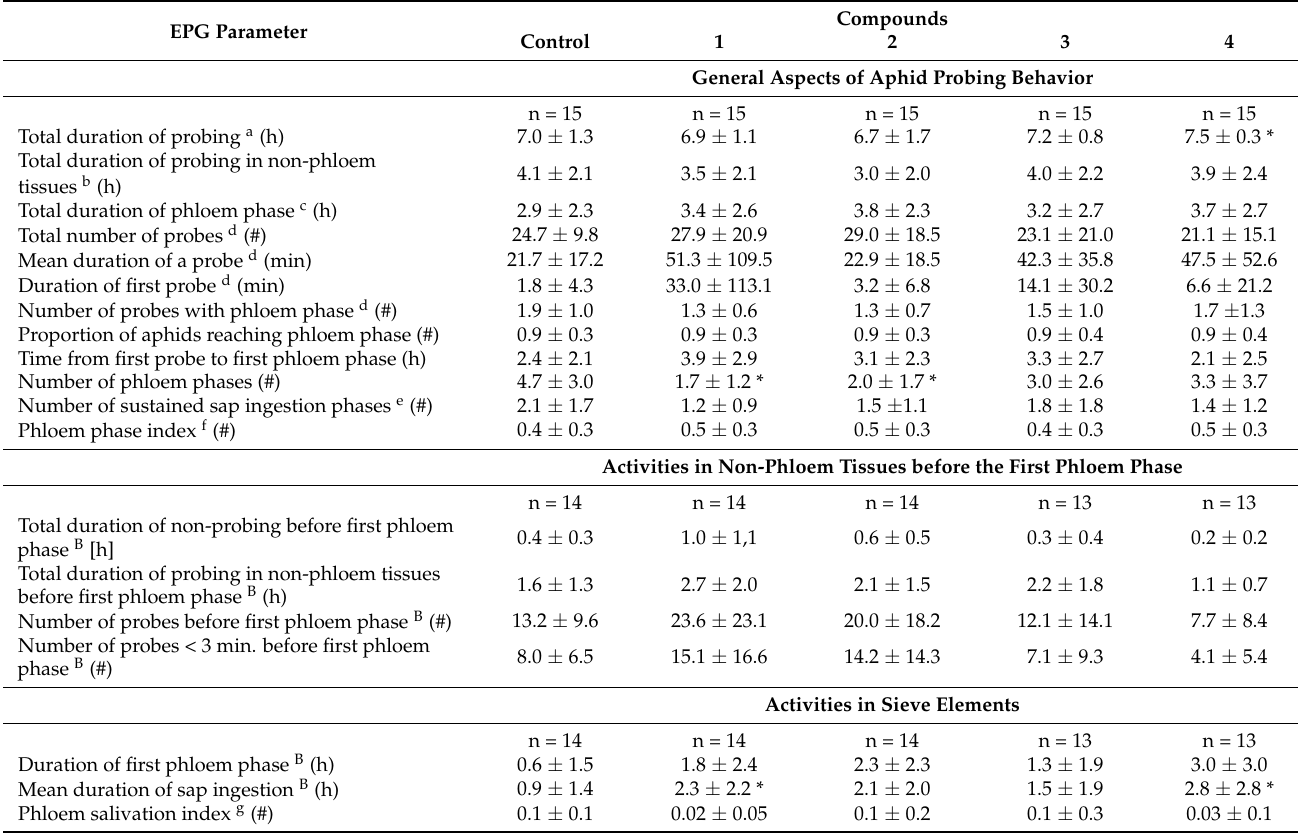
Table 2. Probing behavior (EPG parameters) of Myzus persicae on Brassica rapa subsp. pekinensis leaves treated with geranylacetone ( 1 ), epoxygeranylacetone ( 2 ), nerylacetone ( 3 ), and epoxynerylacetone ( 4 ) A . The same plant was used to maintain the aphid stock